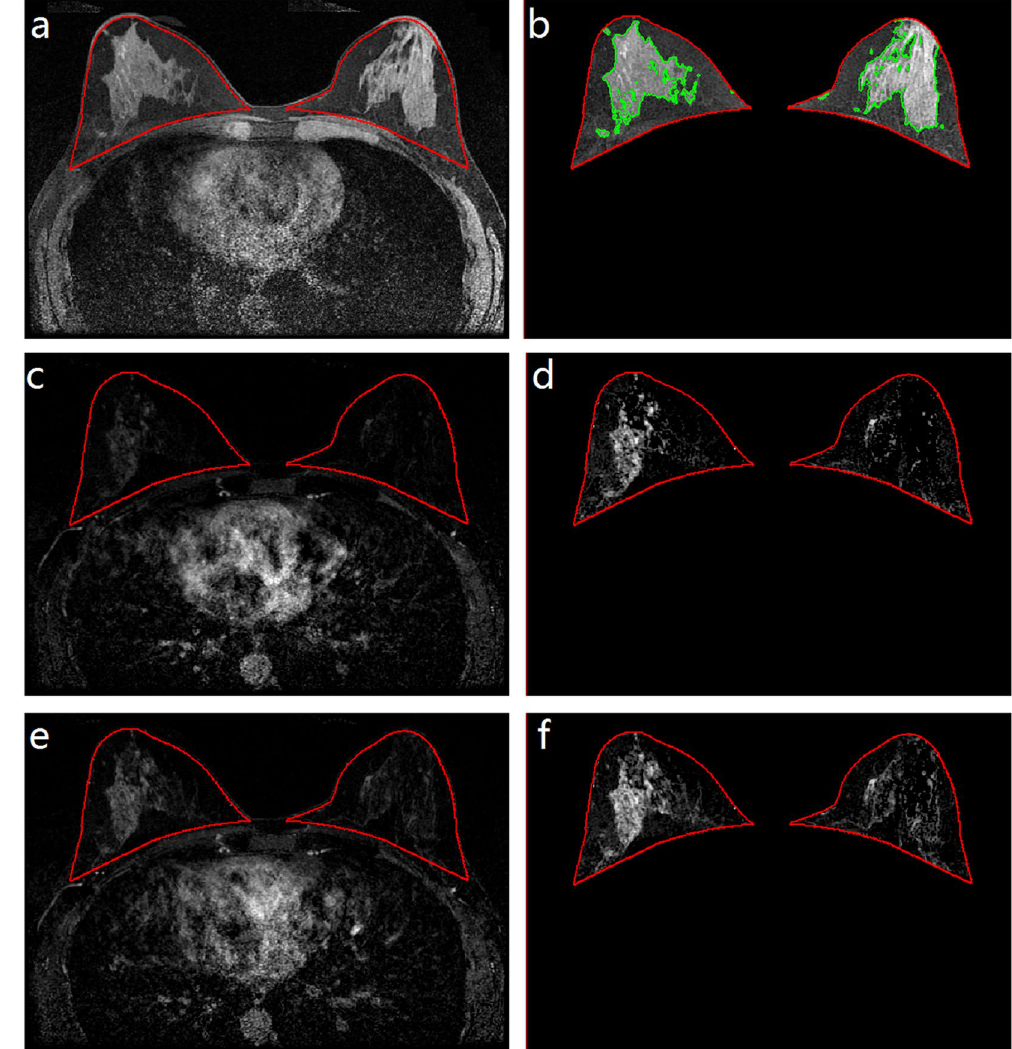
Figure 1. Automated segmentation of background parenchymal enhancement (BPE) and fibroglandular tissue (FGT) from breast DCE-MRI scans. ( a ) Whole-breast segmentation (red contour) from a pre-contrast image. ( b ) FGT (outlined by green contour) estimated from the segmented whole-breast. ( c ) The corresponding first post-contrast-subtracted (SUB1) image with superimposed breast contour (red). ( d ) BPE estimated from the SUB1 image (plot c ). ( e ) The corresponding third post-contrast-subtracted (SUB3) image with superimposed breast contour (red). ( f ) BPE estimated from the SUB3 image (plot e